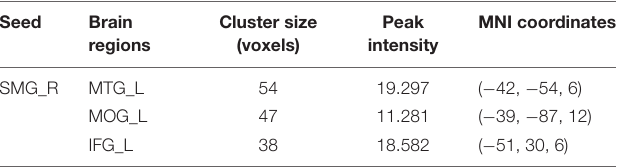
to reduce low-frequency drift and high-frequency